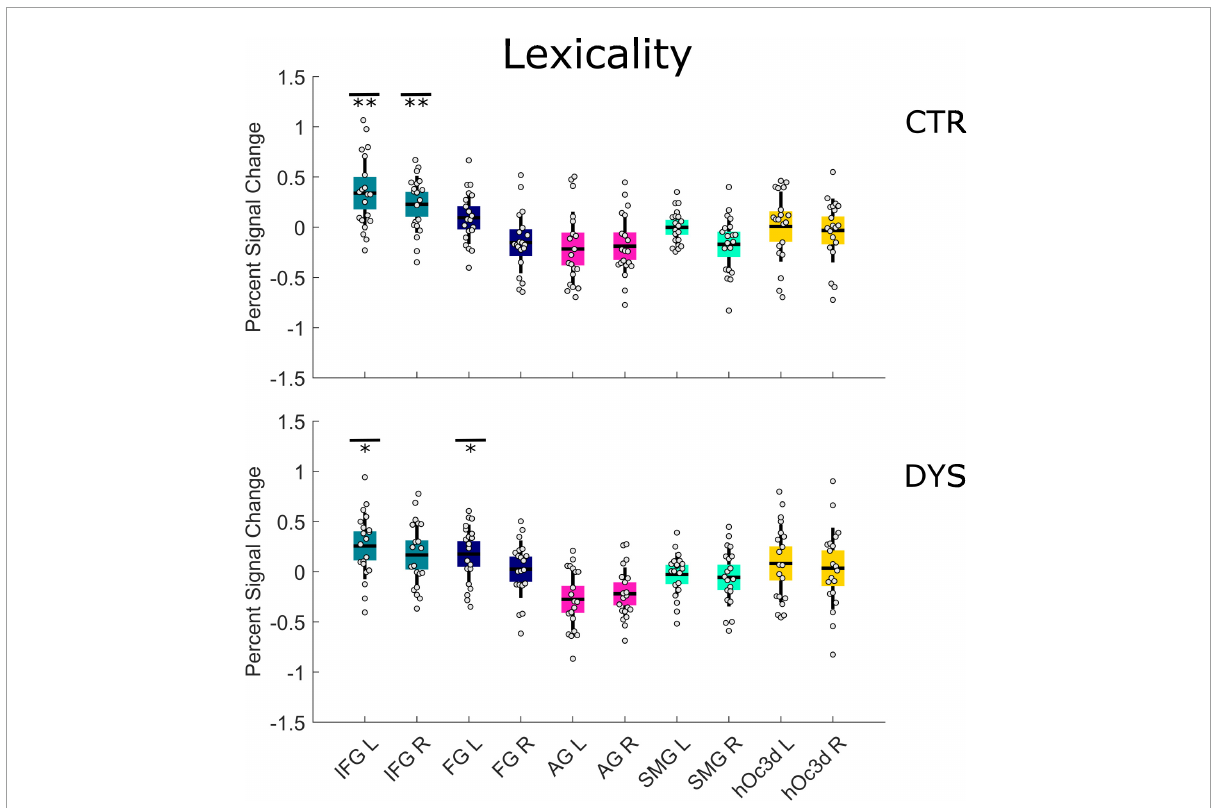
FIGURE6 Univariate ROI results of the Lexicality effect (words minus hash marks). Percent signal change is displayed for each group (DYS and CTR) for each of the 10 predefined ROIs. The asterisks indicate significant effects * p < 0.05 or ** p < 0.01 after correcting for multiple comparisons using FDR. DYS: dyslexic readers, CTR: typical readers, IFG: inferior frontal gyrus, FG: fusiform gyrus, AG: angular gyrus, SMG: supramarginal gyrus, hOc3d: Dorsal extrastriate cortex, L: left hemisphere, R: right